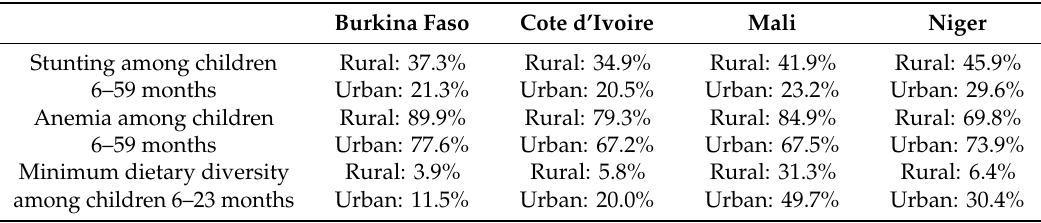
Table 1. Child malnutrition in four target